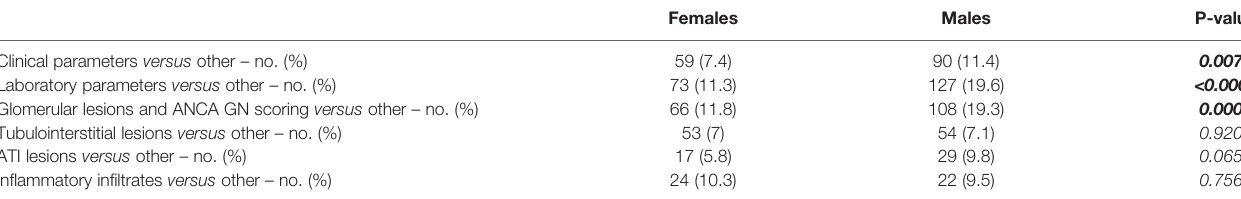
Non-parametric between-group comparisons were performed with Pearson ’ s Chi-square test. Bold indicates statistically signi fi cant values at group level. ANCA, anti-neutrophil cytoplasmic antibodies; ATI, acute tubular injury; GN, glomerulonephritis; no.,